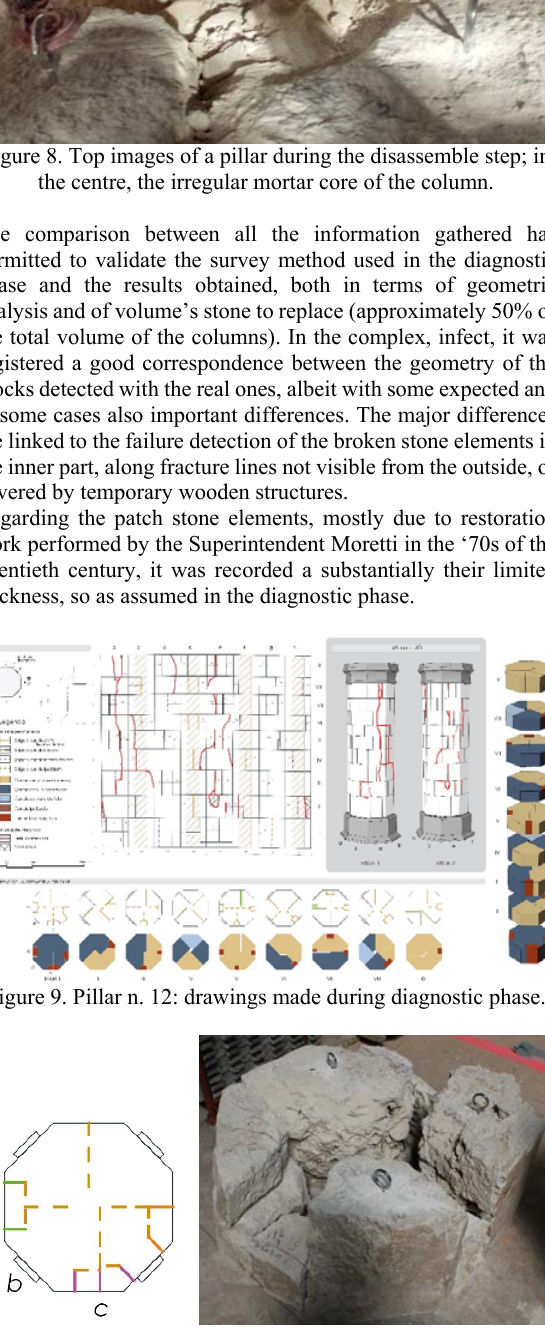
Figure 10. Pillar n. 12 – row I. On the left, diagnostic drawing; on the right the ashlars disassemble and reassemble on the floor of the